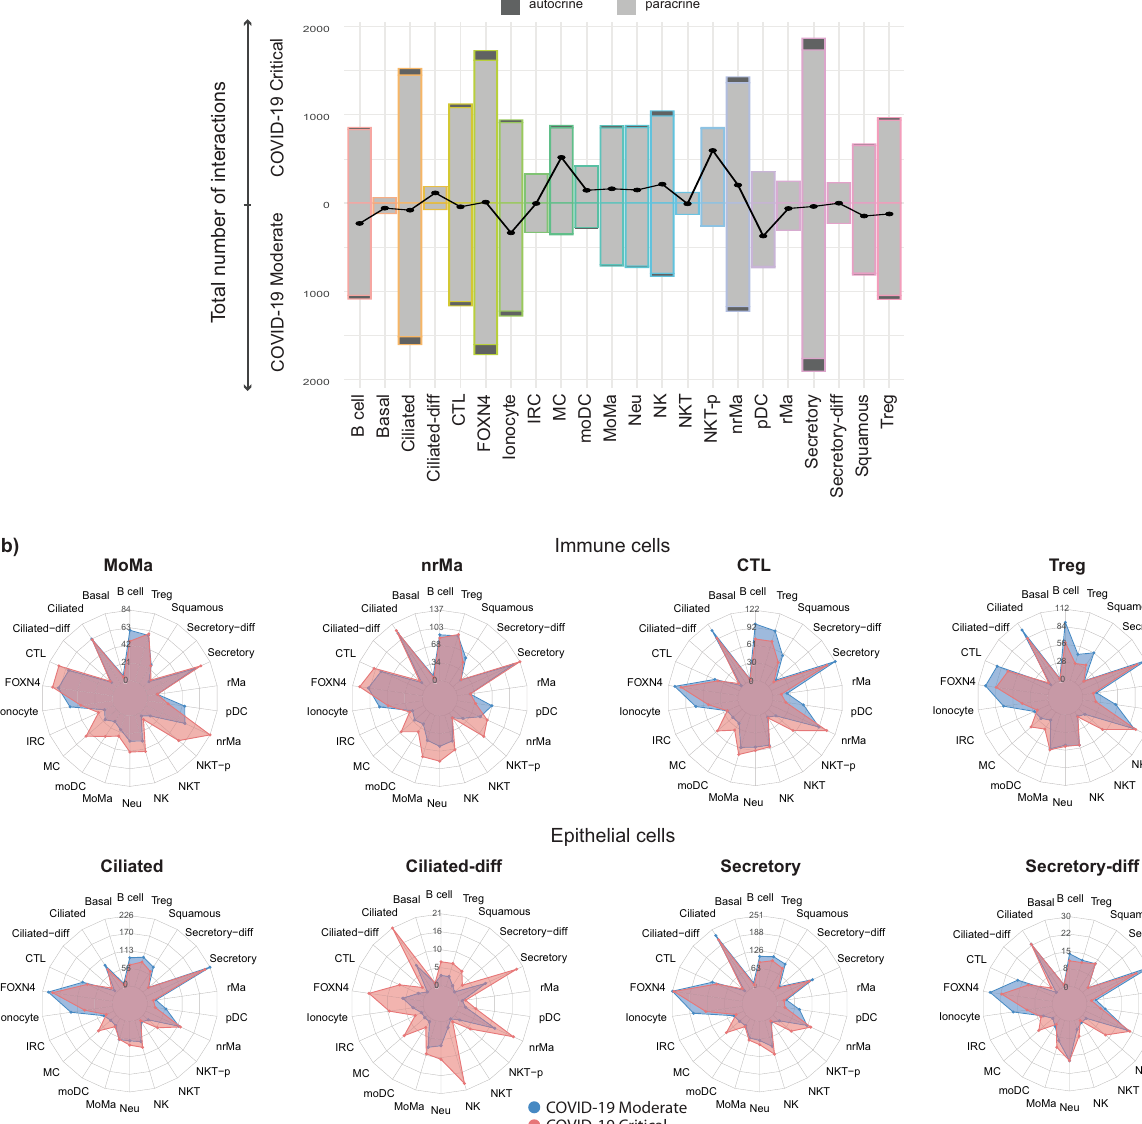
Fig. 4 InterCellar generates comprehensive insights on the number of interactions per cell cluster. a Differences in the total number of interactions per cell type are shown in back-to-back bar plots generated by InterCellar ’ s multiple conditions section. All interaction fl ows are considered (directed-outgoing: L-R pairs, directed-incoming: R-L pairs, and undirected: L-L and R-R pairs). Dots on the black curve represent differences between the number of interactions in critical compared to moderate cases. Both autocrine and paracrine interactions are considered and plotted separately in each bar. Cell types are automatically color- coded by InterCellar for consistency throughout the analysis. See Supplementary Data 1 for source data. b Relative differences in the number of interactions are displayed in the InterCellar multiple conditions section using radar plots, comparing moderate to critical cases. All interaction fl ows are considered. Each plot displays the number of interactions between a speci fi c cell type and all other cell types participating in the communication, ordered alphabetically, counter- clockwise. Cell clusters belonging to the immune cell group are represented in the fi rst row, while epithelial cell types are shown in the second row. Cell types can be grouped in (1) epithelial cells, namely basal, ciliated, ciliated-differentiating (ciliated-diff), FOXN4 + , ionocyte, IFNG responsive cell (IRC), secretory, secretory- differentiating (secretory-diff) and squamous; and (2) immune cells, namely B cell, cytotoxic T cell (CTL), regulatory T cell (Treg), natural killer (NK), natural killer T cell (NKT), natural killer T cell-proliferating (NKT-p), neutrophil (Neu), plasmacytoid dendritic cell (pDC), monocyte-derived dendritic cell (moDC), mast cell (MC), resident macrophage (rMa), non-resident macrophage (nrMa) and monocyte-derived macrophage (MoMa). int-pairs occurring in the communication between secretory cells, between secretory as well as secretory-diff cells and neutrophils secretory-diff, and all other cell types. Here, we analyzed the three (Fig. 5a). Speci fi cally, these int-pairs were detected at varying levels of COVID-19 conditions in parallel, by using the dot plot functionality expression in the two disease conditions, while they were completely provided in the gene-verse. In particular, by looking at int-pairs absent in control samples. This fi nding con fi rms the hypothesis of composed of selected chemokine ligands mentioned in Chua et al. 6 the authors concerning neutrophil recruitment induced by secretory ( CXCL1 , CXCL3 , CXCL6 , CXCL16 , and CXCL17 ), we could observe cells 6 . However, no relevant difference could be recognized between a clear enrichment of ligand − receptor pairs in the communication moderate and critical cases.